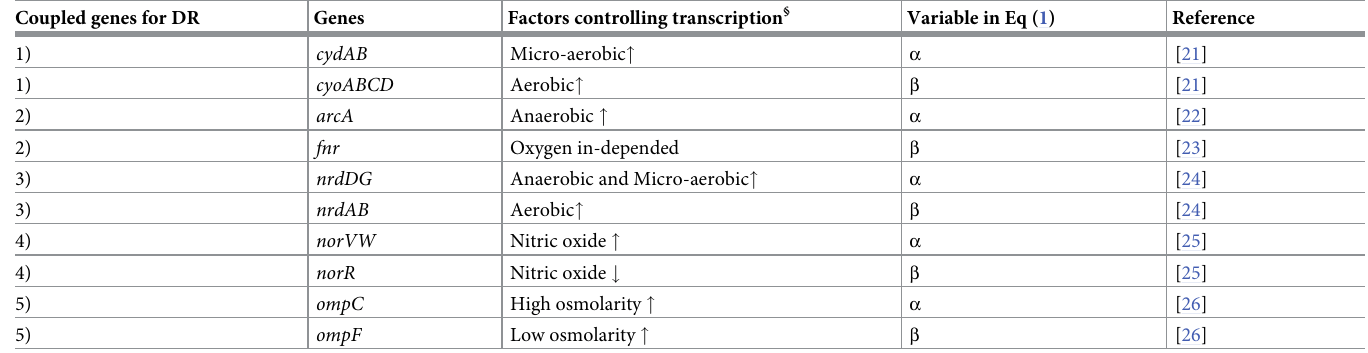
§ Arrow direction indicates whether the controlling factor up or down regulate transcription of the